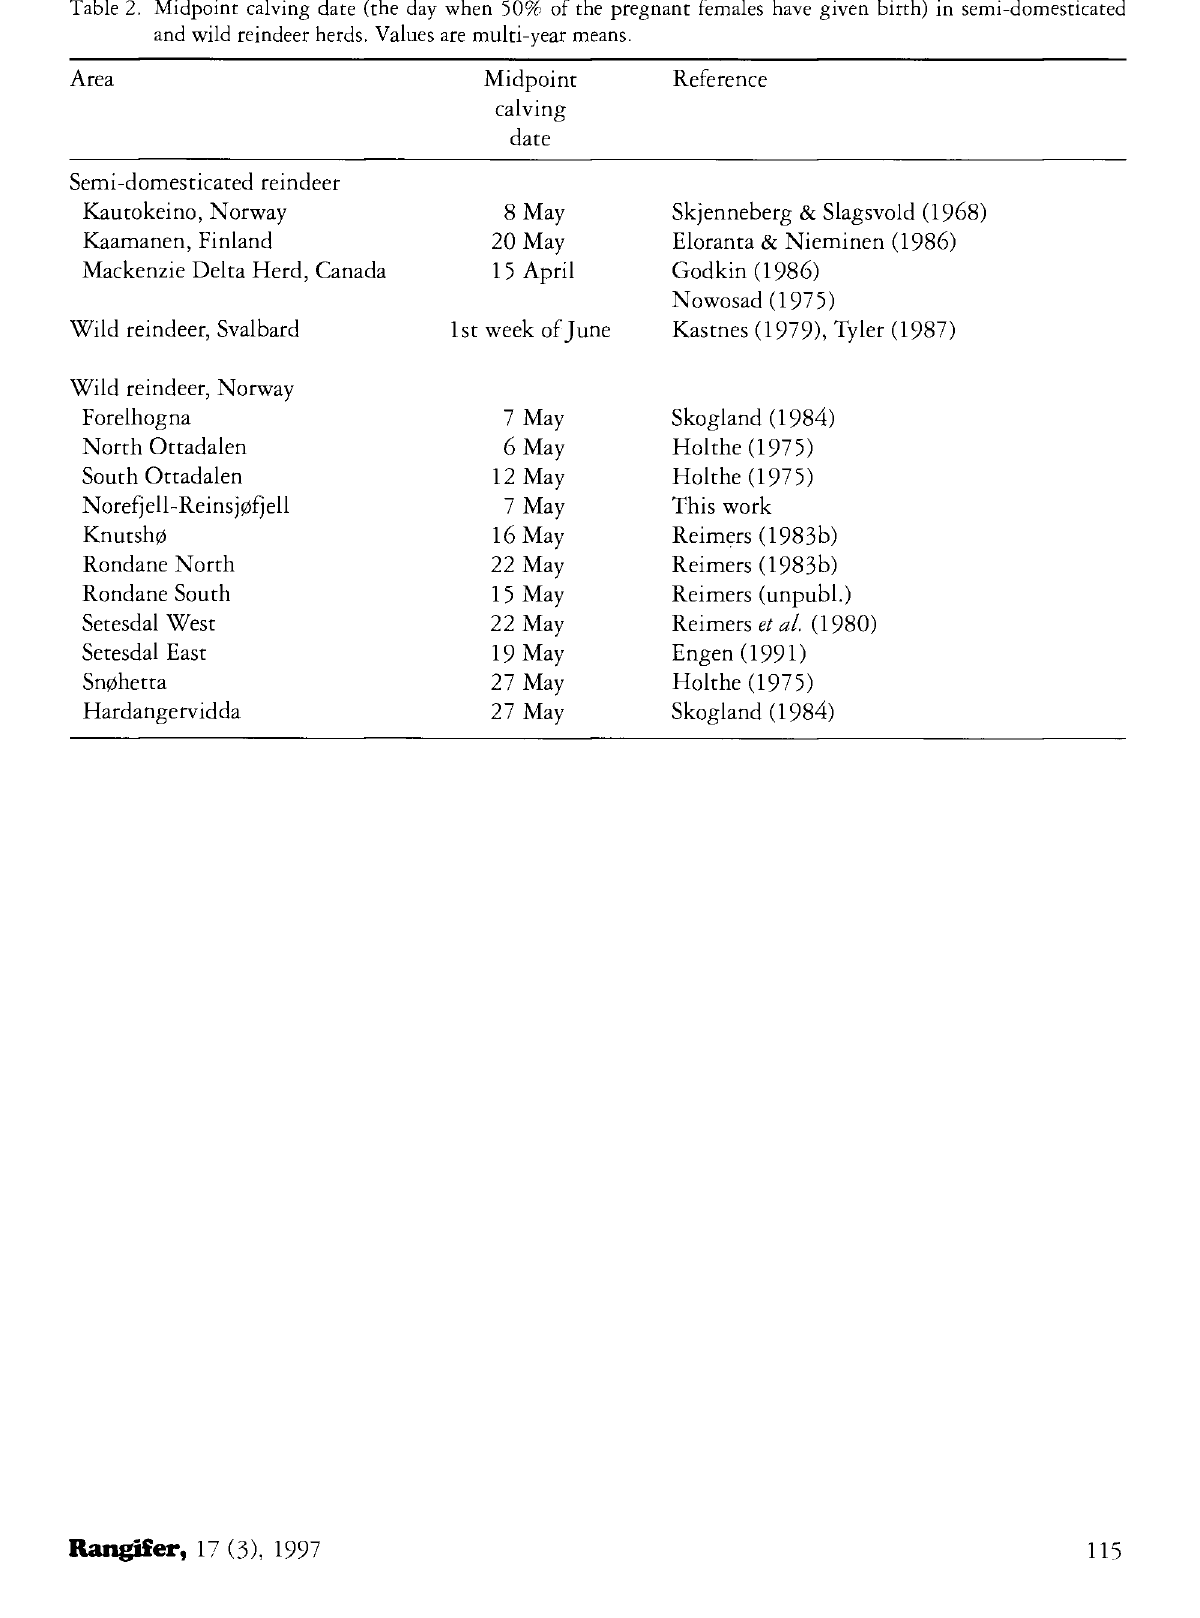
Table 2. Midpoint calving date (the day when 50% of the pregnant females have given birth) in semi-domesticated and wild reindeer herds. Values are multi-year